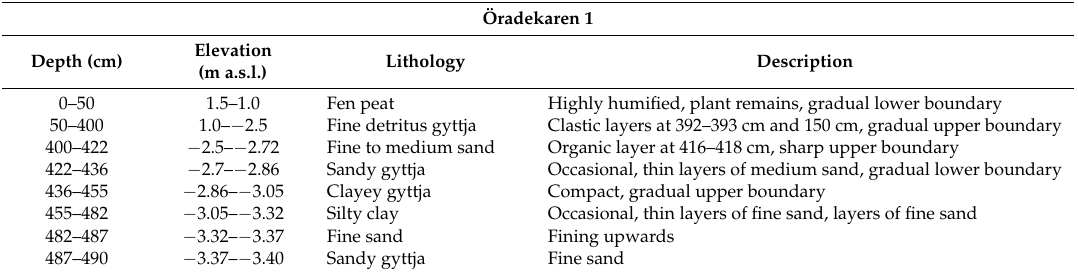
Table 1. Lithostratigraphy of the Öradekaren 1 sediment sequence. 14 C dates are listed in Table 2.